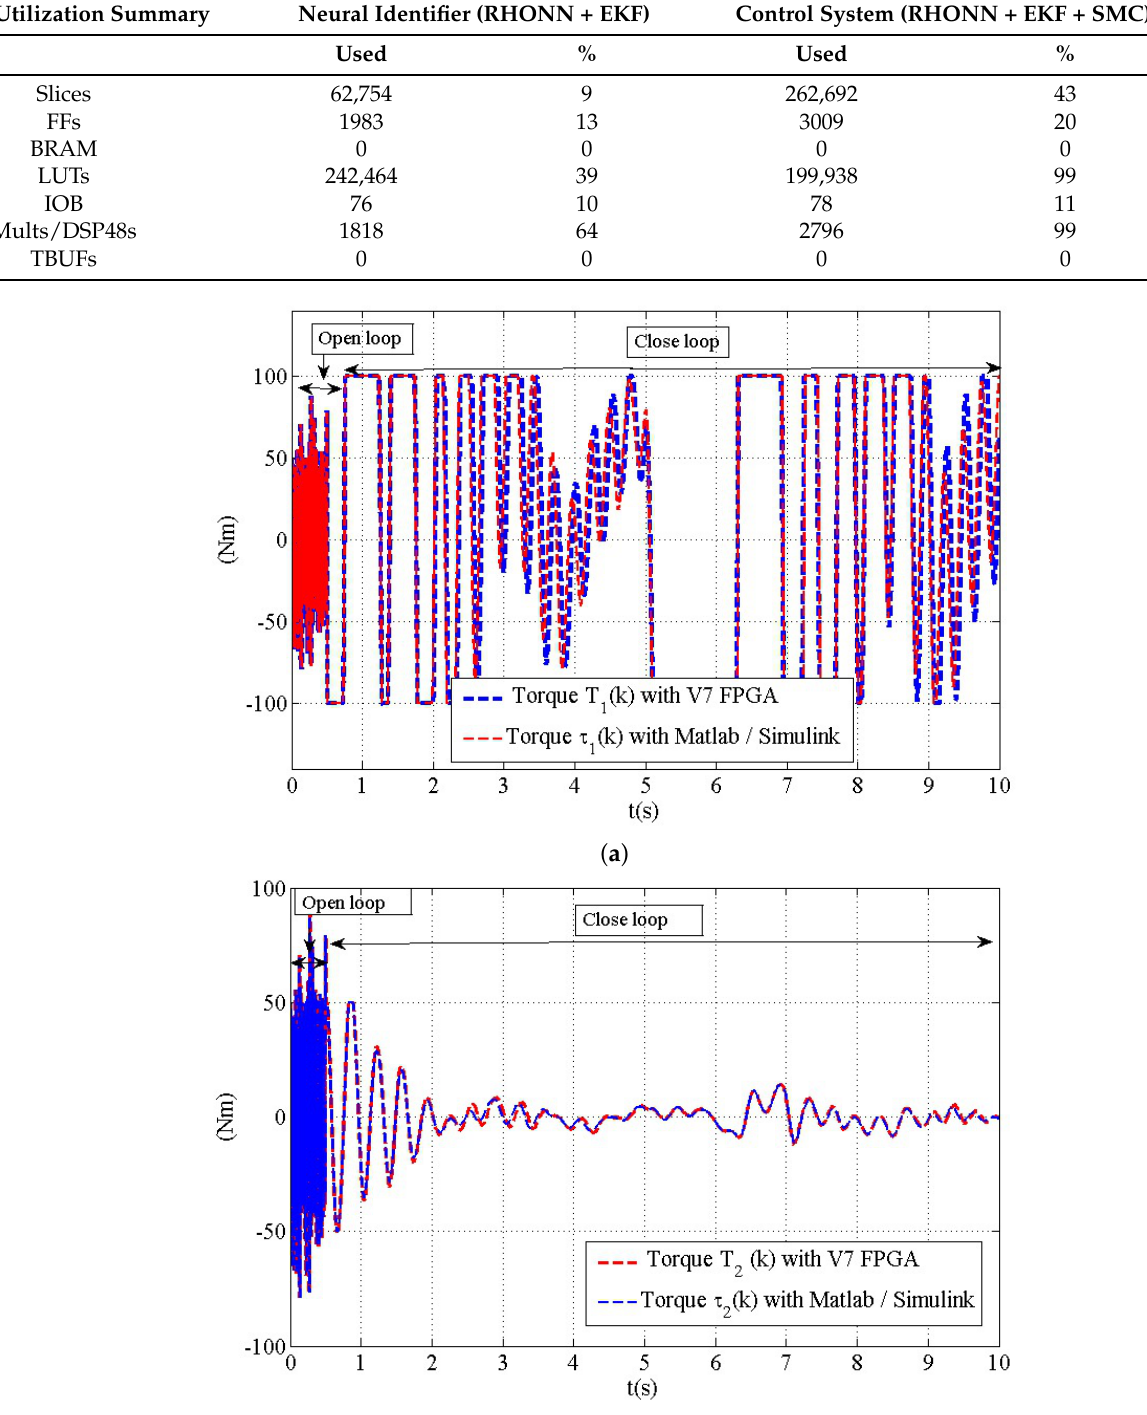
Table 1. Hardware resource utilization of logic circuits used in the hardware-in-loop architecture.